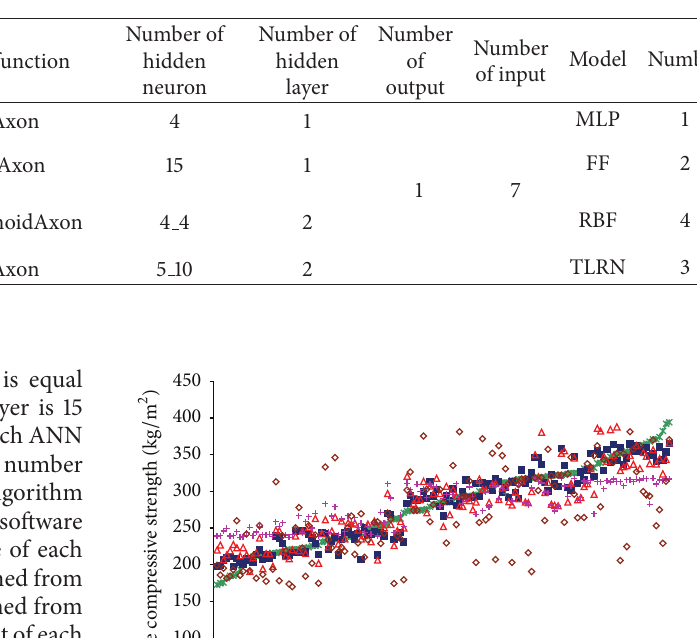
Table 3: Optimal structure of MLP, FF, RBF, and TLRN models obtained from GA.